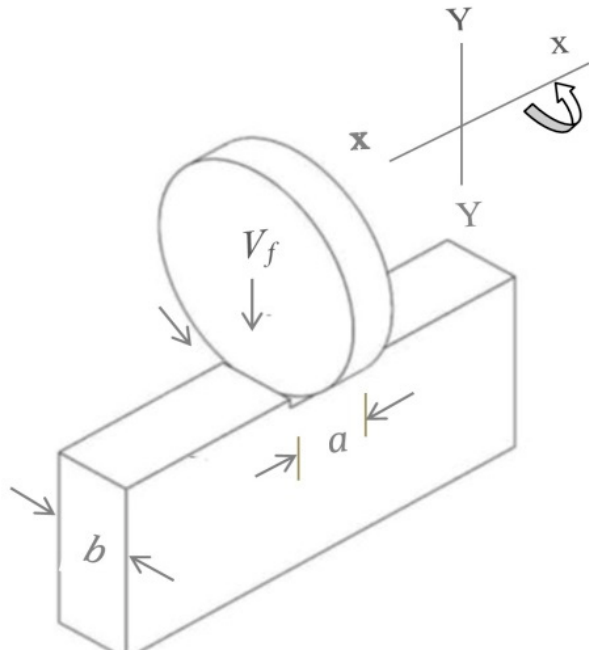
Figure 6. Cutting cross section.